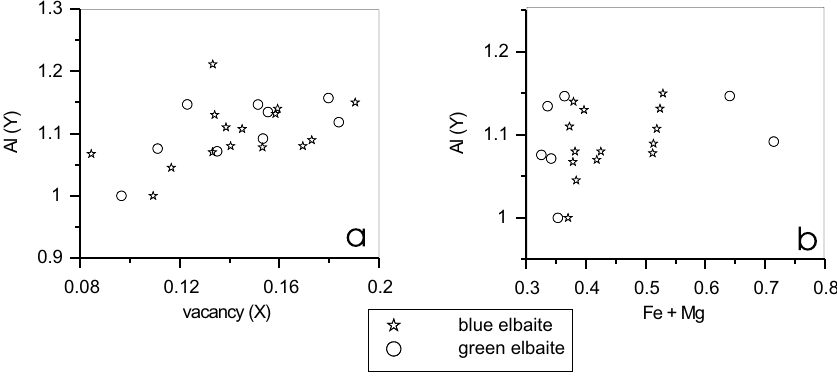
Fig. 4 – (a) Al in the Y site vs. vacancy in the X site of blue and green elbaites; (b) Al in the Y site vs. (Fe + Mg) of blue and green